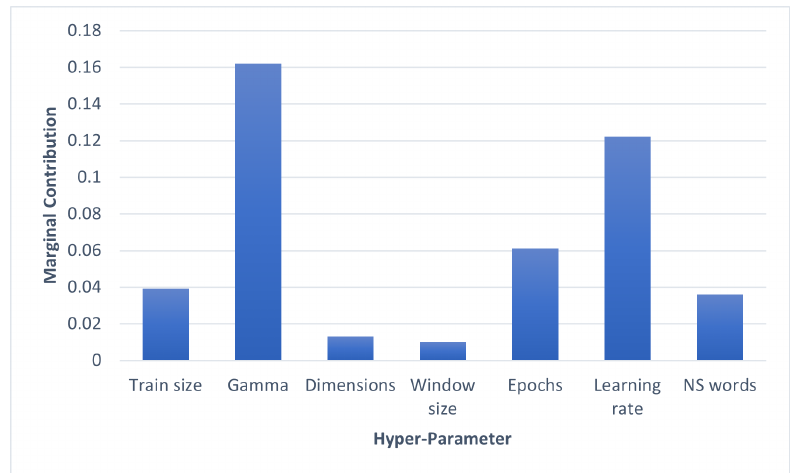
Figure 7. Marginal contribution of each hyper-parameter, as predicted by the functional Analysis of Variance